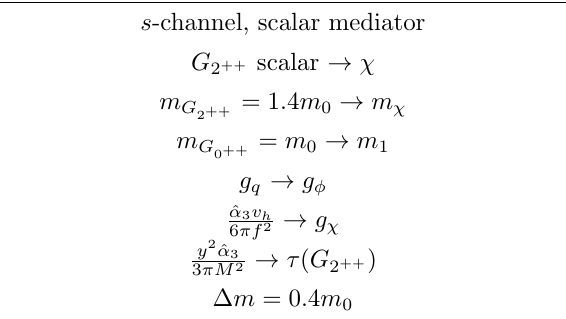
Table 6 . Map of twin glueball parameters to the simpli(cid:12)ed models. The (cid:12)rst (cid:12)ve rows characterise the DM simpli(cid:12)ed model while the last two rows are the additional parameters required by the displaced vertices simpli(cid:12)ed